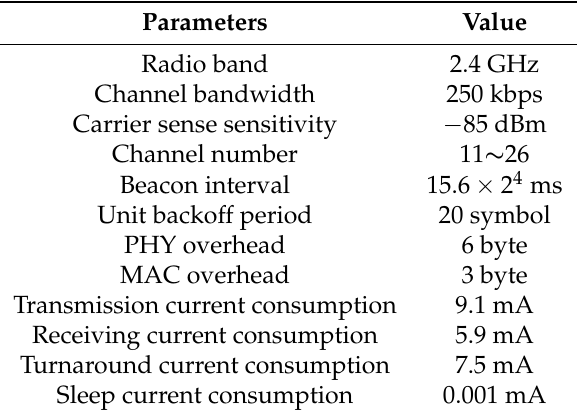
Table 2. Simulation parameters.